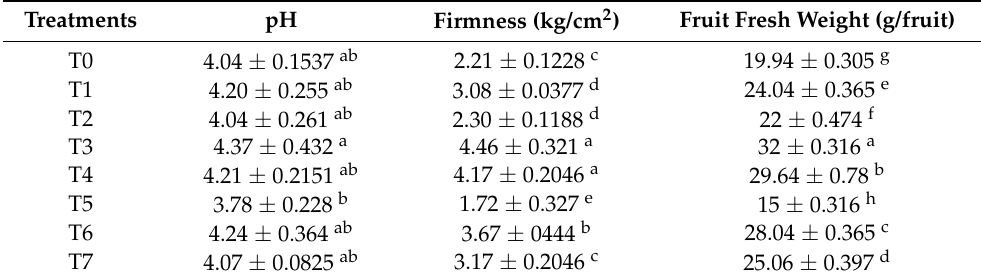
Table 4. Effect of SWE on mitigating salt stress on fruit juice pH, fruit firmness (kg/cm 2 ) and